Question: What style of plot is this figure drawn as?
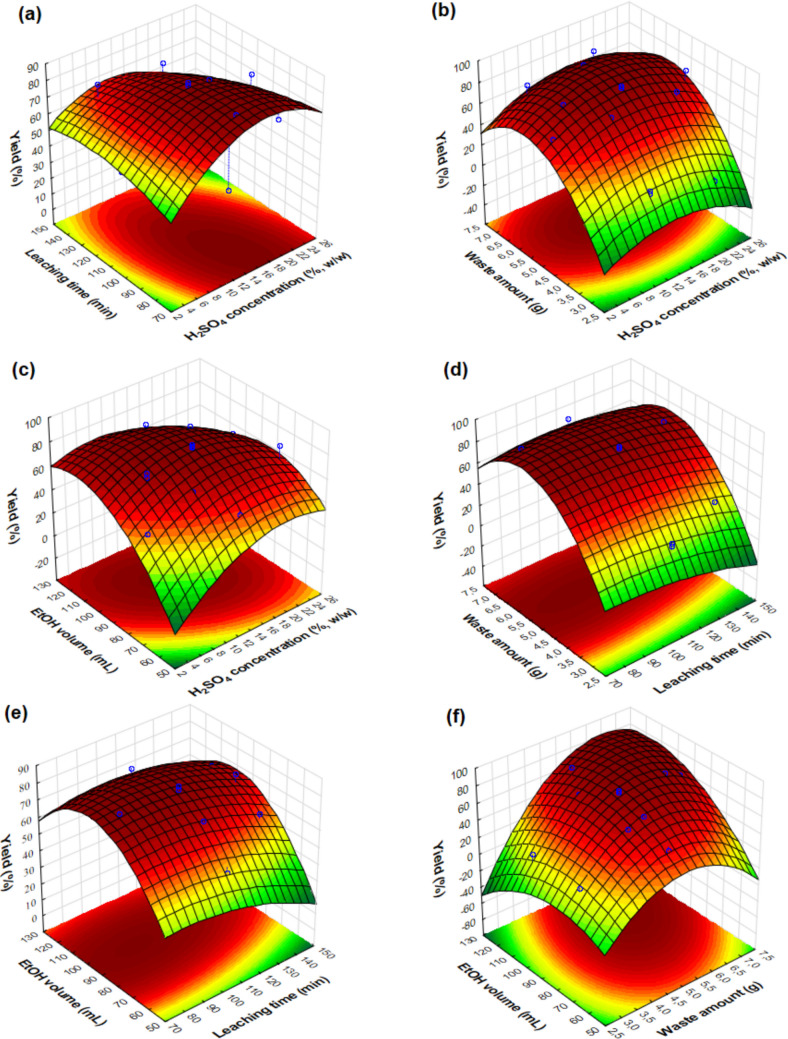
Answer: line